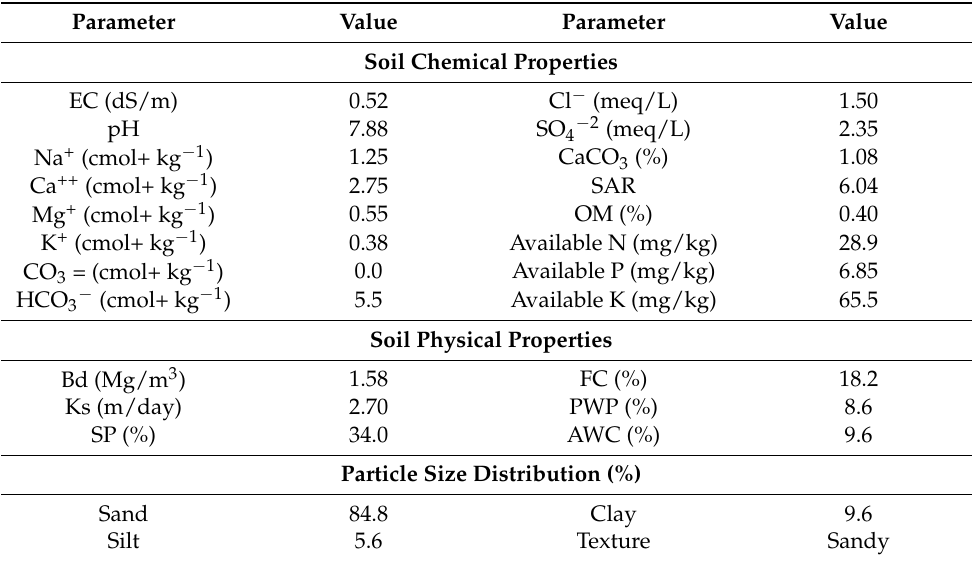
Table 2. Chemical and physical characteristics of the studied